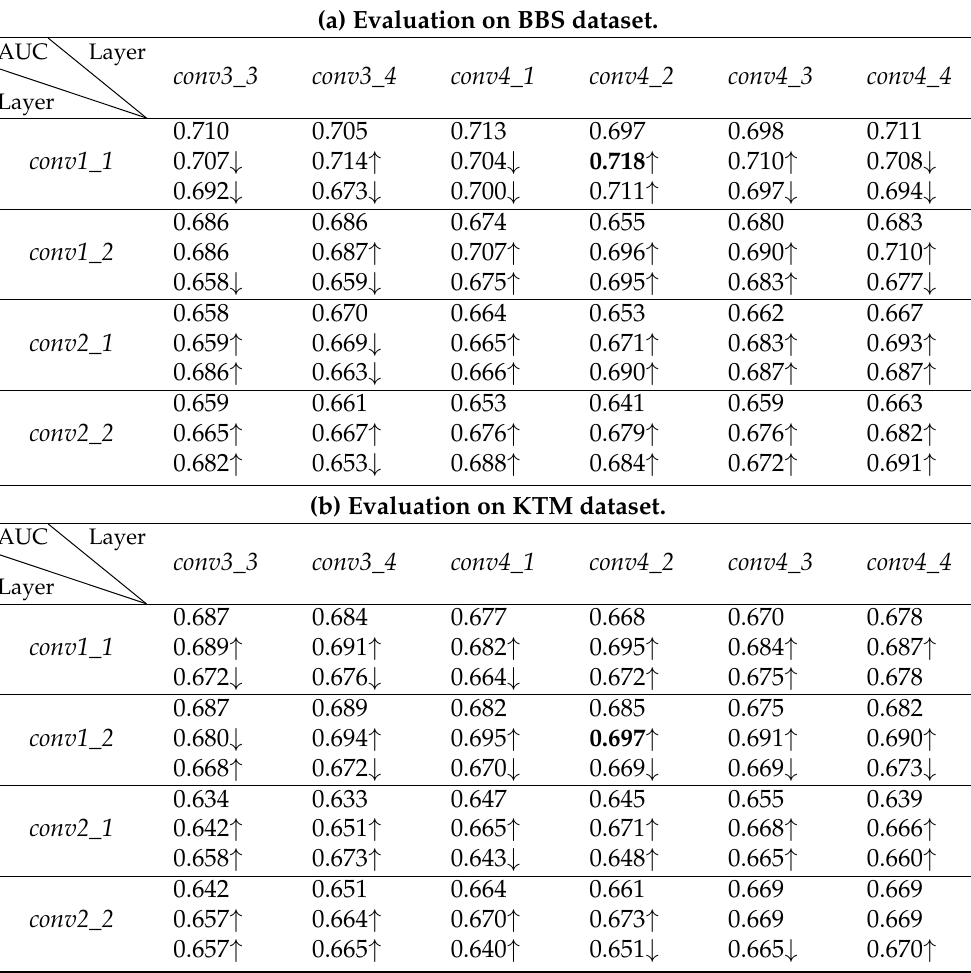
Table 2. Partial AUC scores of DIM using features from two convolutional layers of Model_A (upper value in each cell), Model_D (middle value in each cell), and Model_E (lower value in each cell). The up and down arrows indicate whether the AUC score of Model_D or Model_E is better or worse than that of Model_A. (a) Evaluation on BBS dataset.